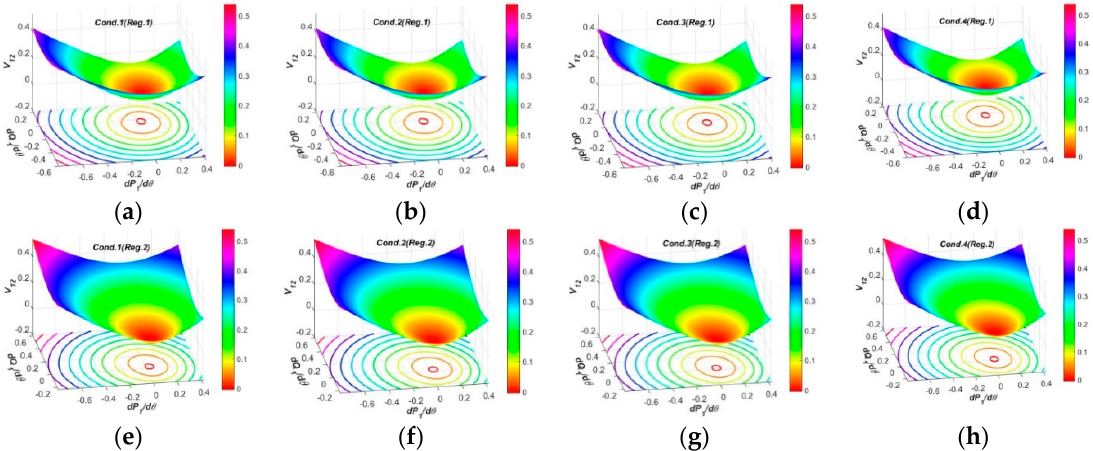
Figure 3. Spatial surfaces of PFG to CIV2 at SCP1 in spaces: ( a – d ) Spatial surfaces of PFG to CIV2 by Reg.1 mode of output series inserted voltage (OSIV) in four operation conditions; ( e – h ) Spatial surfaces of PFG to CIV2 by Reg.2 mode of OSIV in four operation conditions.